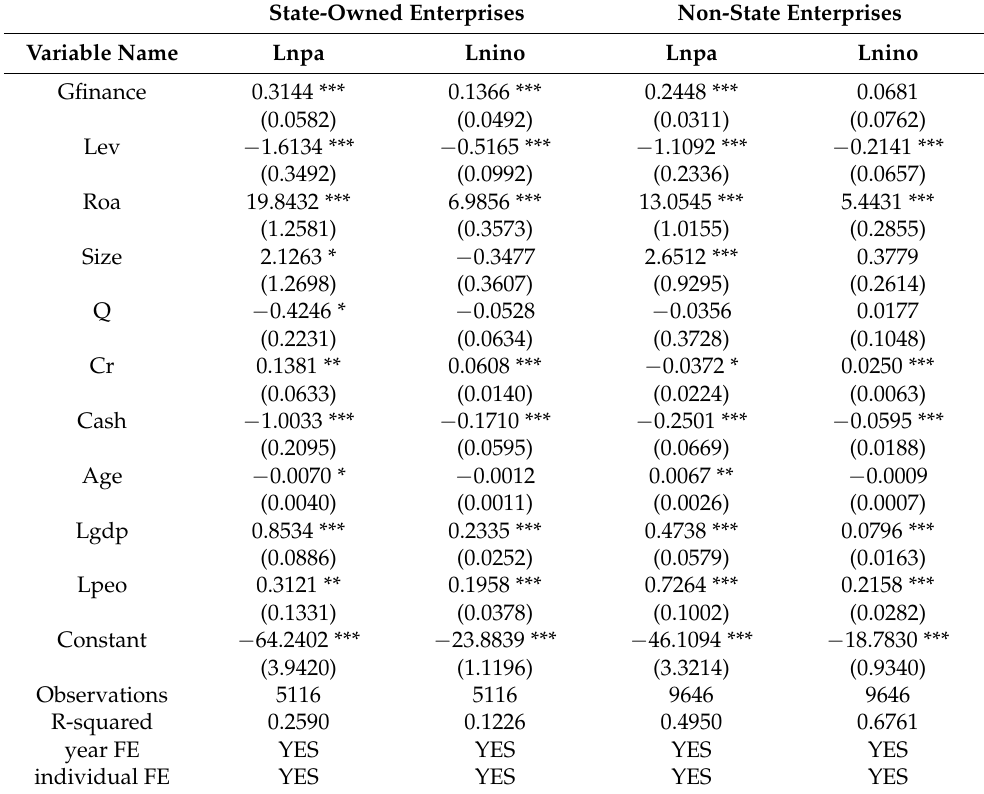
Table 10. Regression results for enterprises with different ownership